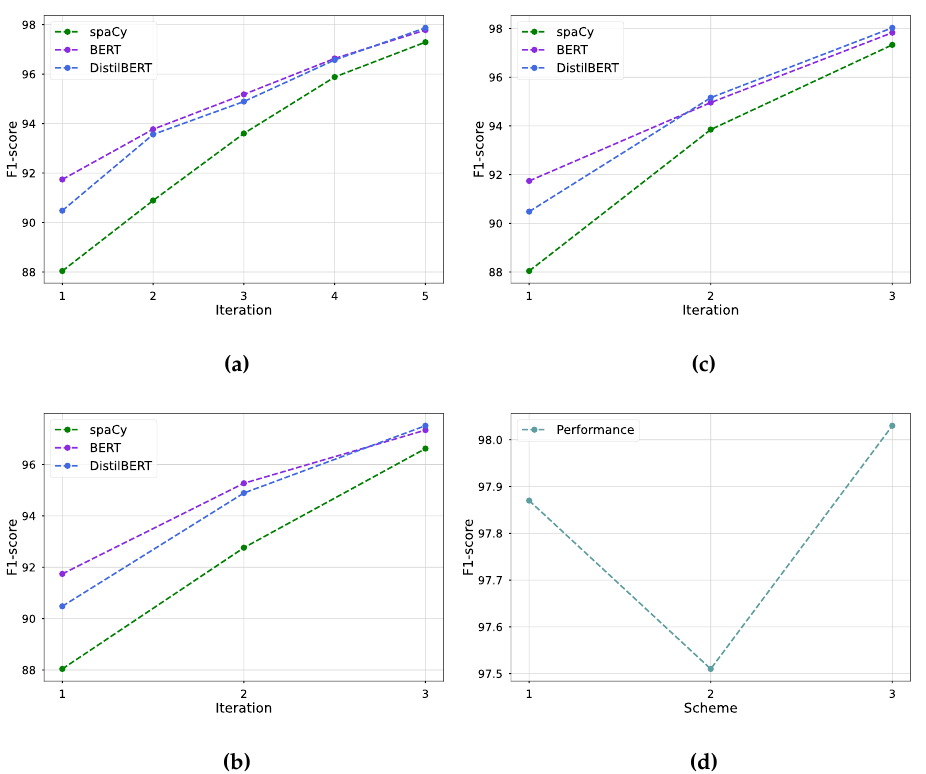
Figure 7. The performance results from 3 different schemes. Each scheme has a different total number of data processing for each iteration: ( a ) scheme 1, s = 2; ( b ) scheme 2, s = 5; ( c ) scheme 3 s = 10; and ( d ) best performance in each scheme. Table 7. Computation time and their aspect of the proposed method. As the training set grows, the labeling time increases. Note that the three schemes increase the labeled set